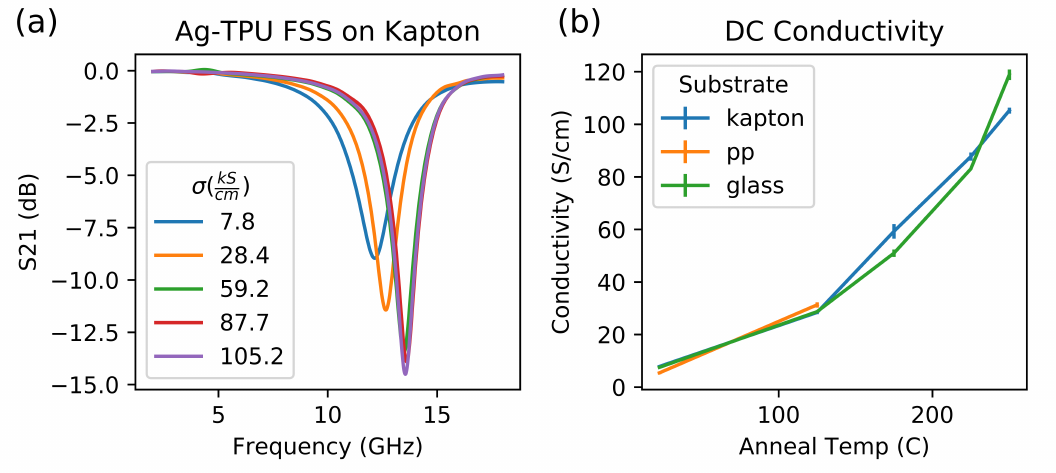
Figure A15. ( a ) Simulated ideal spiral FSS S 21 response over 0–20 GHz while varying conductivity of Ag-TPU on a Kapton substrate at DC conductivity values, ( b ) Measured DC Conductivity of Ag-TPU on Kapton, polypropylene (PP), and glass as a function of annealing temperature. Note: PP annealing is limited by substrate melting